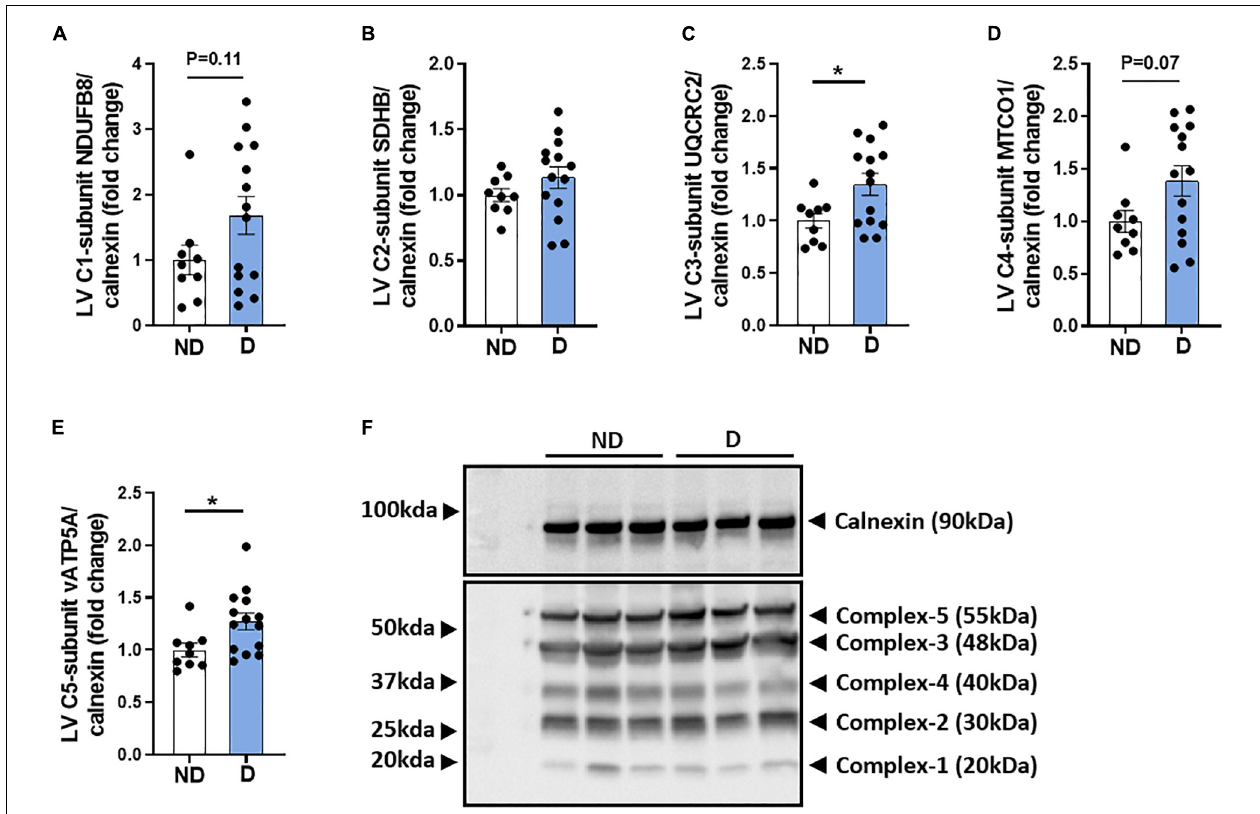
FIGURE 5 | Protein abundance of mitochondria complexes in diabetic mice. Western blot quantification of (A) LV complex-I-subunit NDUFB8/calnexin, (B) LV complex-II-subunit SDHB/calnexin, (C) LV complex-III-subunit UQCRC2/calnexin, (D) LV complex-IV -subunit MTCO1/calnexin, (E) LV complex-V -subunit vATP5A/calnexin. (F) Representative blot images of mitochondria complexes. Data represented as mean ± SEM. n = 9–14 per group (note individual data points). Data analysis used unpaired t -test. * P < 0.05. ND, non-diabetic; D, diabetes; LV, left